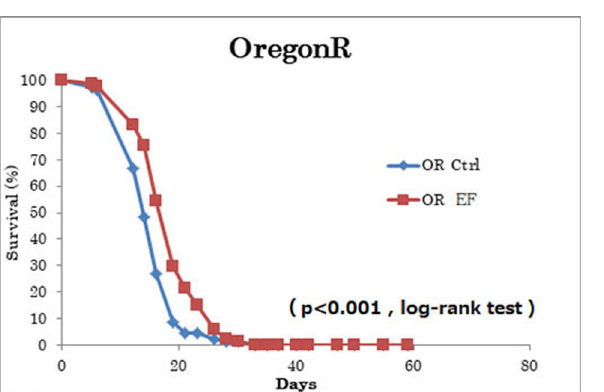
Figure 2. Exposure to EF significantly prolonged average lifespan of WT flies maintained under low nutrient food conditions. Evaluation of senescence status in EF exposed flies (n = 89) versus shame flies (n = 85). Flies under low nutritional status were exposed to 50-Hz EF. This experiment was repeated 3 times. p < 0.001, log- rank test. EF electric field, WT wild type (Oregon